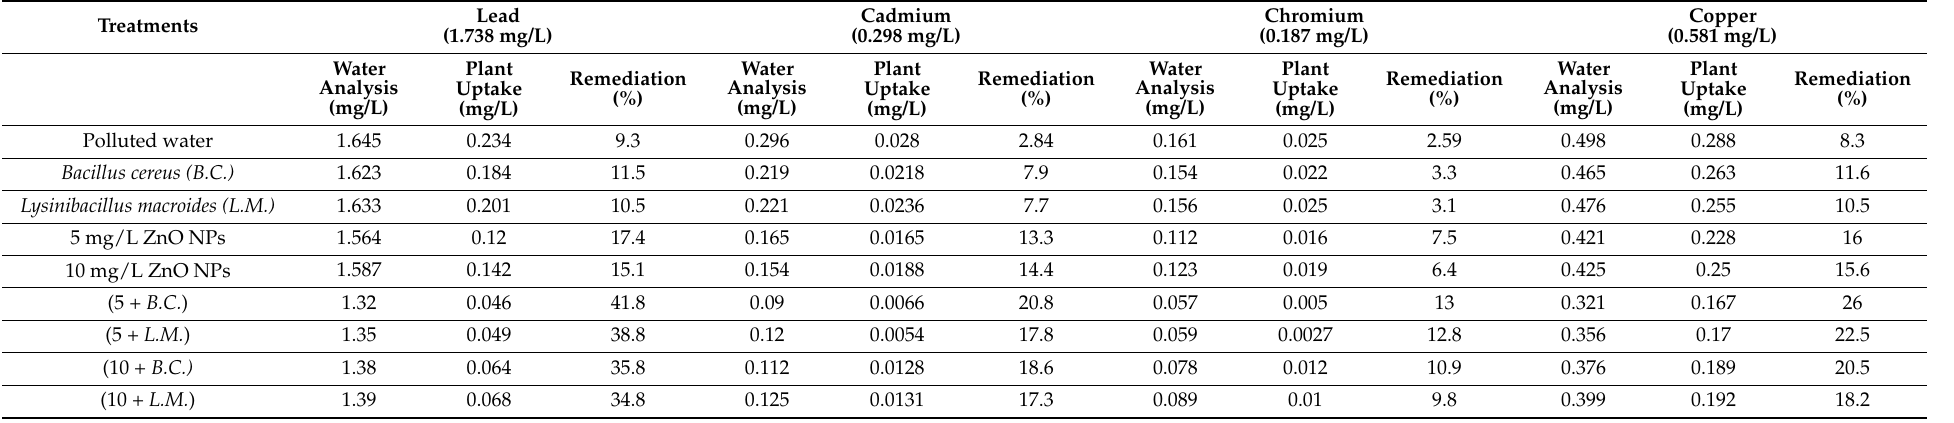
Table 2. Synergistic effects of the bacterial strains ( Bacillus cereus and Lysinibacillus macroides) and ZnO NPs (5 and 10 mg/L) on heavy metal uptake (mg/L) and reduction (%) of rice seedling grown in HM polluted water.